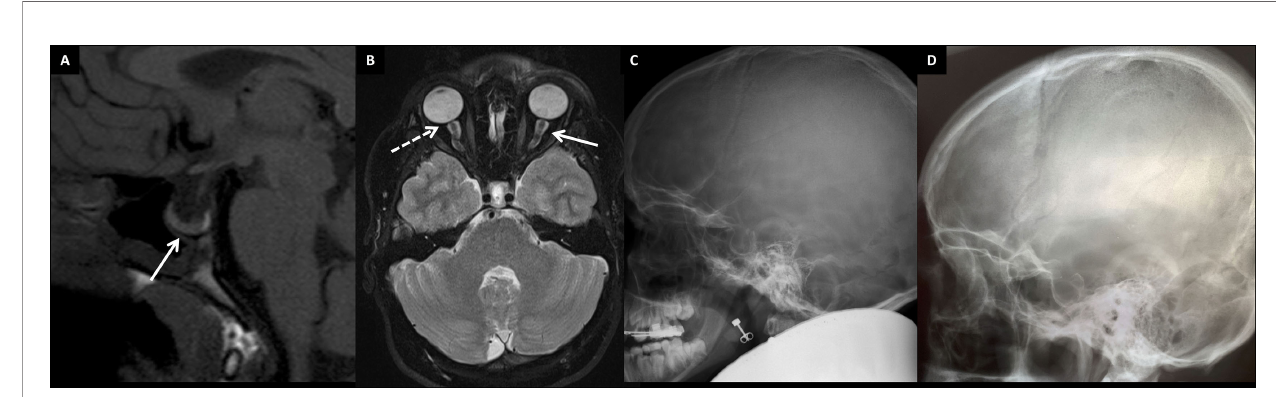
FIGURE 6 | Brain structure fi ndings in two patients with the novel skeletal dysplasia. (A) Non-enhanced T1 sagittal MR image showing an enlarged pituitary fossa fi lled mainly with CSF and pituitary tissue lining the sellar fl oor (arrow). The bright spot behind the adenohypophysis represents neurohypophysis at the normal position in the 13-year-old female index (III-1). (B) Tortuous optic nerves with distended perioptic nerve sheaths (arrow), and optic globe fl attening ( fl attening of the posterior part; dashed arrow) in the 13-year-old female index. Skull radiographs of the female index (III-1) (C) and her father (II-1) (D) showing an enlarged pituitary fossa in